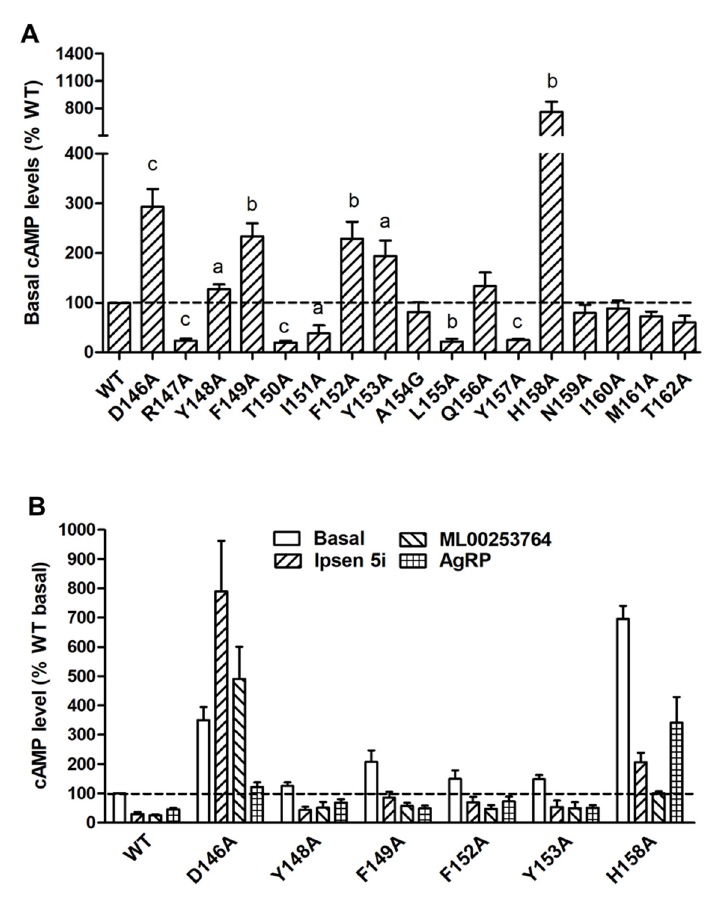
Figure 4. Constitutive activity of WT and mutant MC4Rs in the cAMP pathway. ( A ) HEK293T cells were transiently transfected with WT and mutant MC4Rs, and intracellular cAMP levels were measured by RIA without NDP-MSH stimulation. Results are expressed as % of basal WT cAMP level ± S.E.M. of at least three independent experiments. The basal cAMP level of WT MC4R was 41.45 ± 4.38 pmol / 10 6 cells. The significant di ff erence between WT and mutant: a, p < 0.05; b, p < 0.01; c, p < 0.001. ( B ) Partial inverse agonism of Ipsen 5i, ML00253764, and AgRP (83-132) on WT and six mutants with high basal activities. HEK293T cells were transiently transfected with WT and six mutant MC4Rs. Cells were treated with 10 − 6 M Ipsen 5i, 10 − 5 M ML00253764, or 10 − 8 M AgRP (83-132), and intracellular cAMP levels were measured by RIA. Significant di ff erences are observed between all control and treatment groups ( p < 0.05).